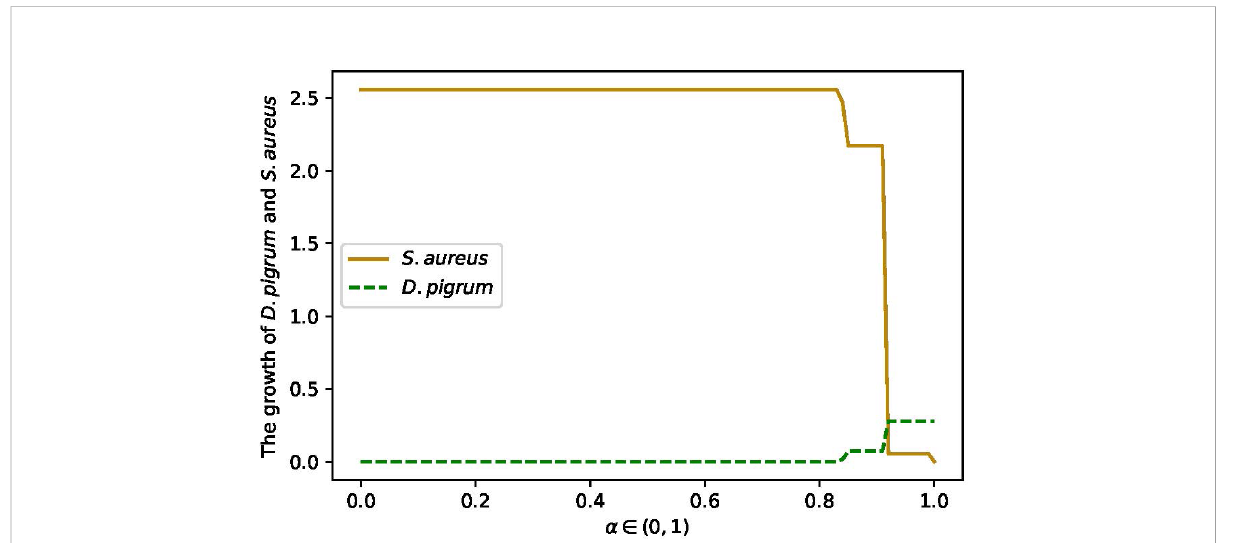
FIGURE 6 The changes in growth rate of D. pigrum and S. aureus in respect to a de fi ned in the community objective function a % MBR DP + (1 − a )% MBR SA in COMPM.